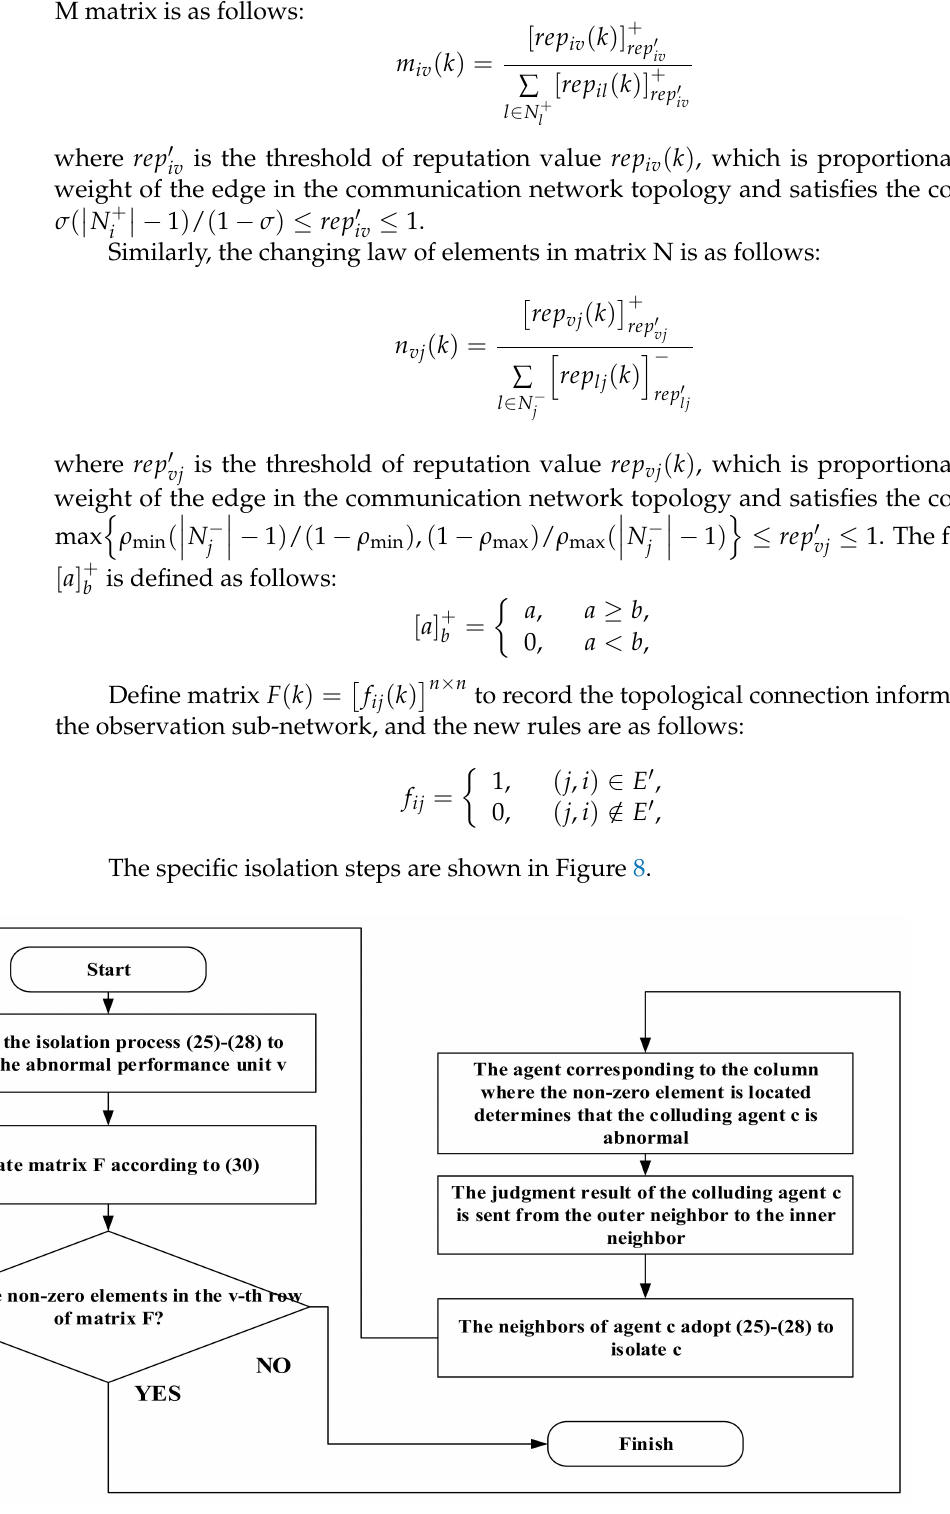
Figure 8. The flow chart of attack isolation process against colluding